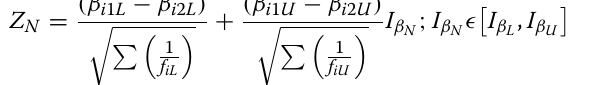
Distressed couples W tN + 1